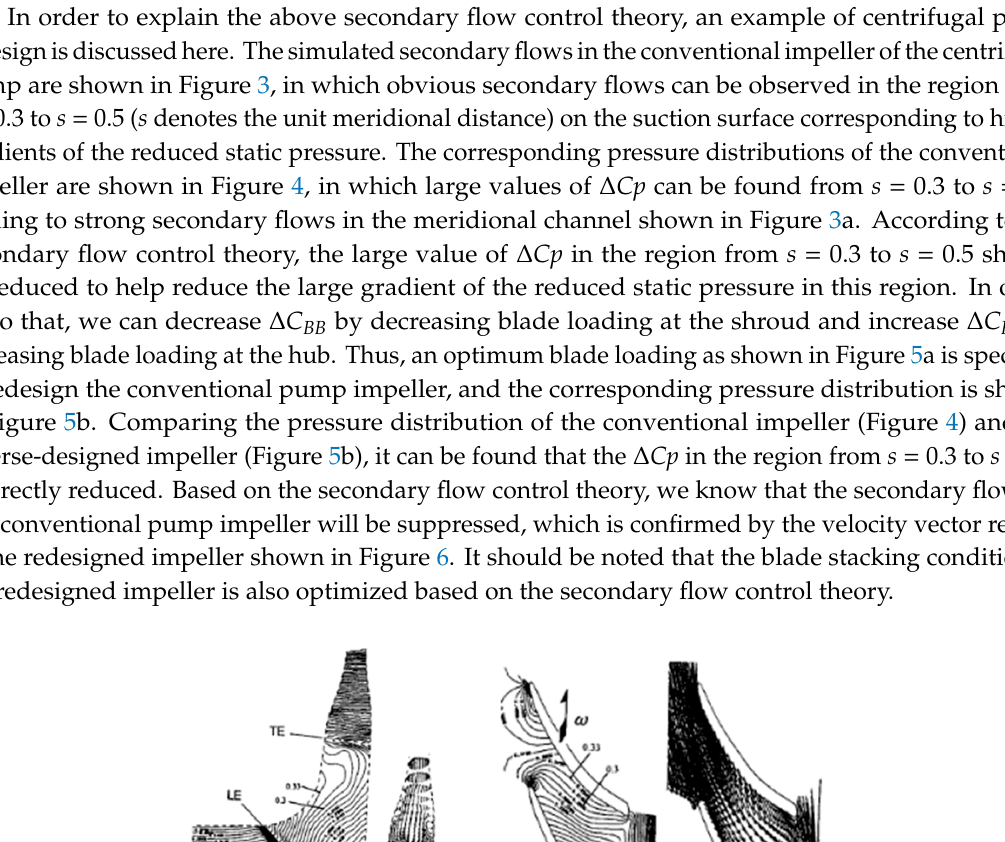
Figure 2. Effect of blade lean on pressure distribution.